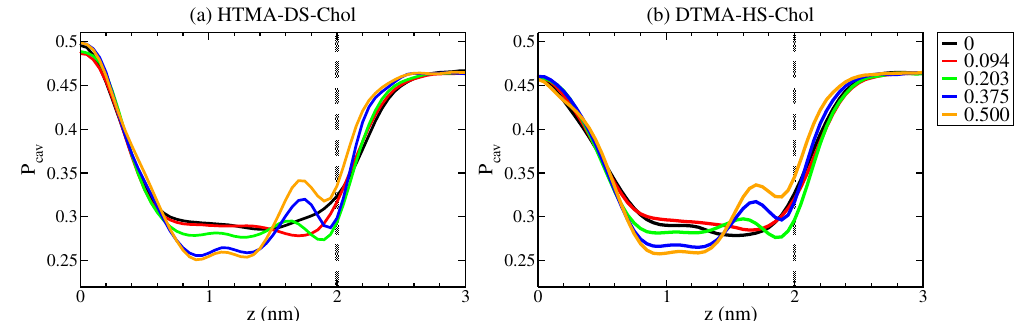
Figure 3. Cavity density profile P cav ( z ) of ( a ) HTMA-DS-Chol and ( b ) DTMA-HS-Chol bilayers at various X chol with the standard deviations of less than 0.015. Error bars are not shown for